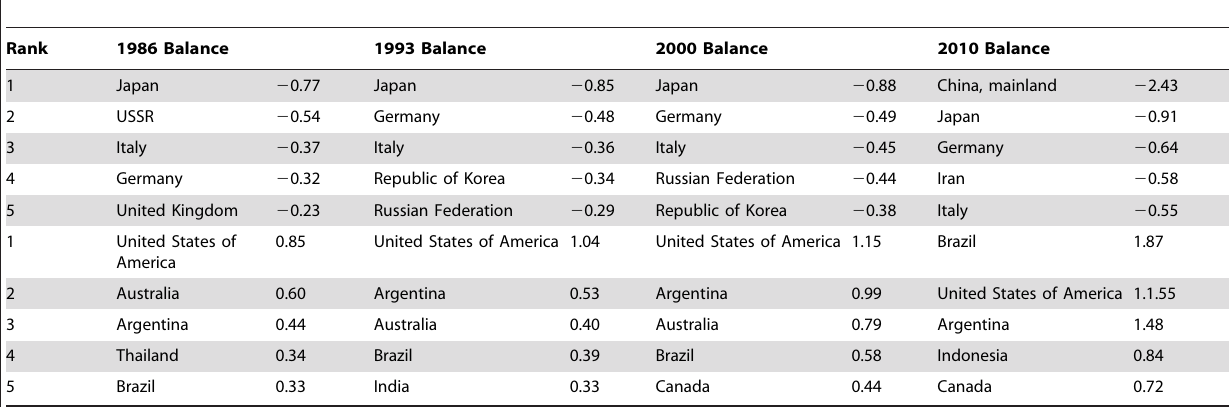
Table 1. The top 5 net importers (top) and exporters (bottom) and their virtual water export import balance (10 11 m 3 ) for the years 1986, 1993, 2000 and 2010.